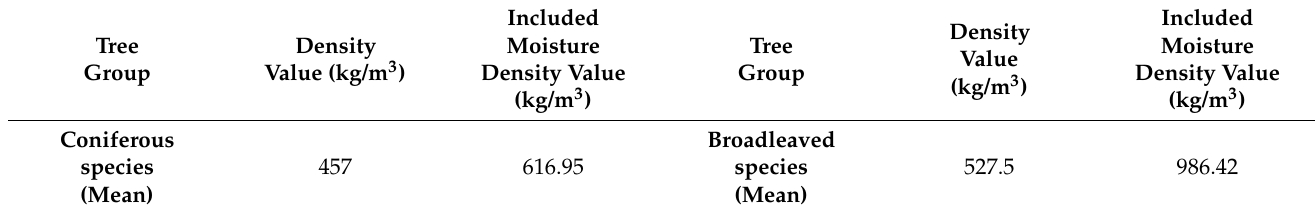
Table 13. Included moisture density values for tree